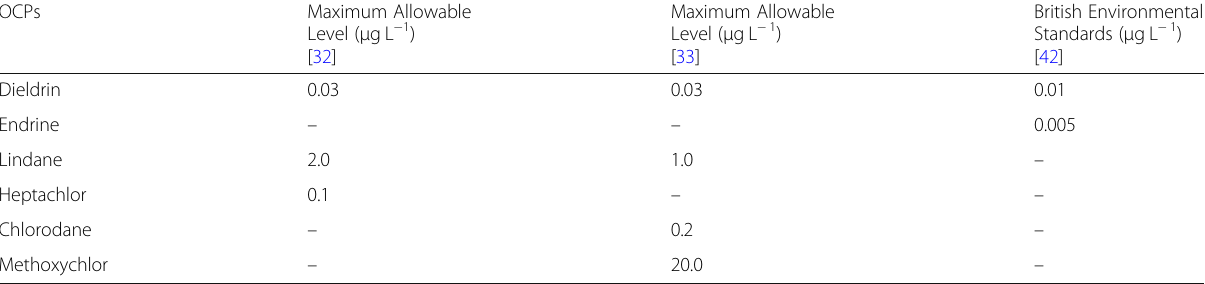
Table 6 World Health Organization, Egyptian Standards and British Environmental Quality Standards for OCPs in drinking water